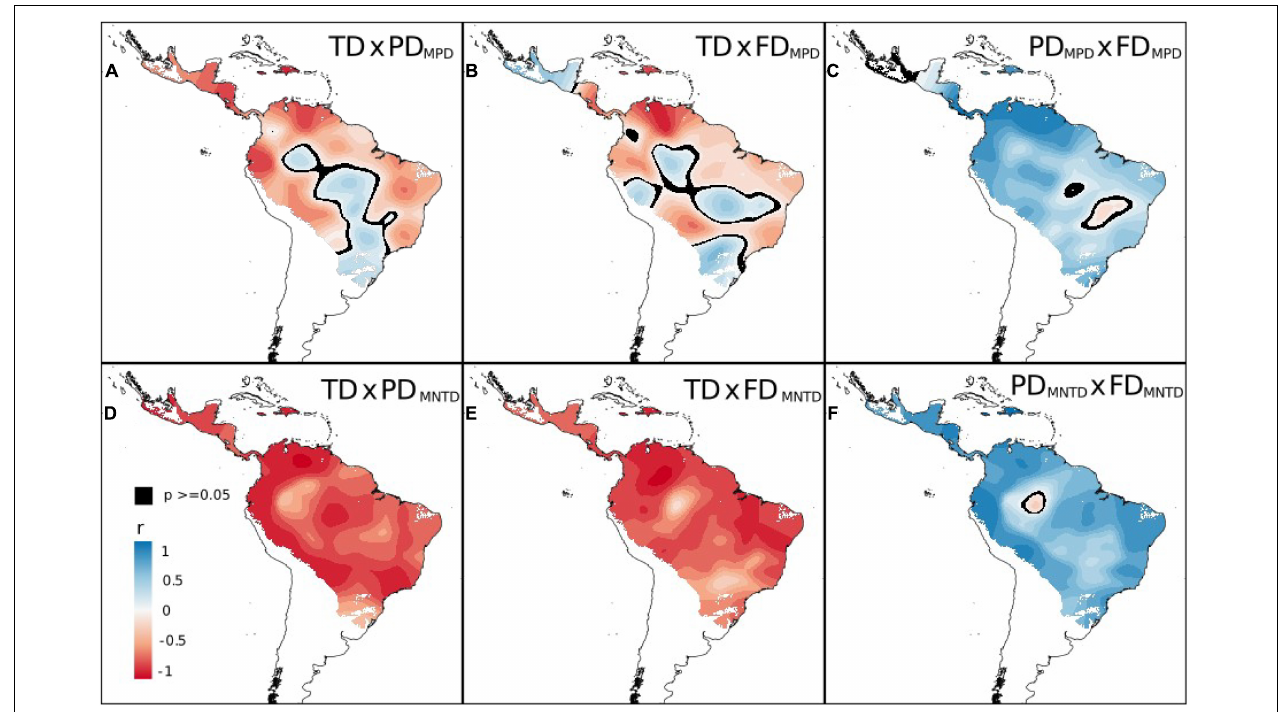
FIGURE 2 | Spatial patterns in correlation between taxonomic (TD), phylogenetic (PD), and functional diversity (FD) of cocosoid palm species in the Neotropics using Geographically Weighted Correlation. Values range from 1 (positive—blue regions) to − 1 (negative—red regions) in the map. MPD, Mean pairwise distance. MNTD, mean nearest taxon distance. In black, areas where p -value are above